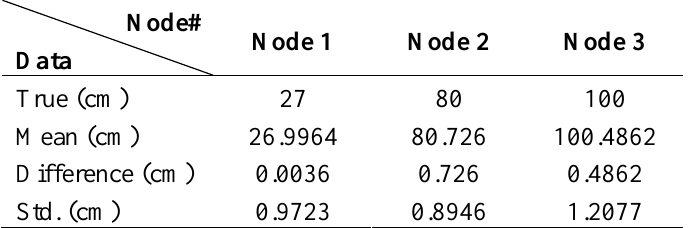
Table 2. Performance evaluation of the distance measurement system.